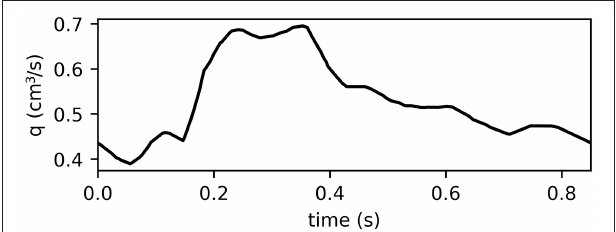
FIGURE 2 | Inlet function for MCA simulations obtained from patient-specific measurements used to represent one period of 0.85s of the pulse wave. The final 10 peaks of the velocity time series were averaged in the Fourier space and adjusted such that its range of values aligns with those reported in Olufsen et al. (2002). The resulting inlet function is smooth and serves as the inlet boundary condition for the MCA simulations using VaMpy (Diem and Bressloff,